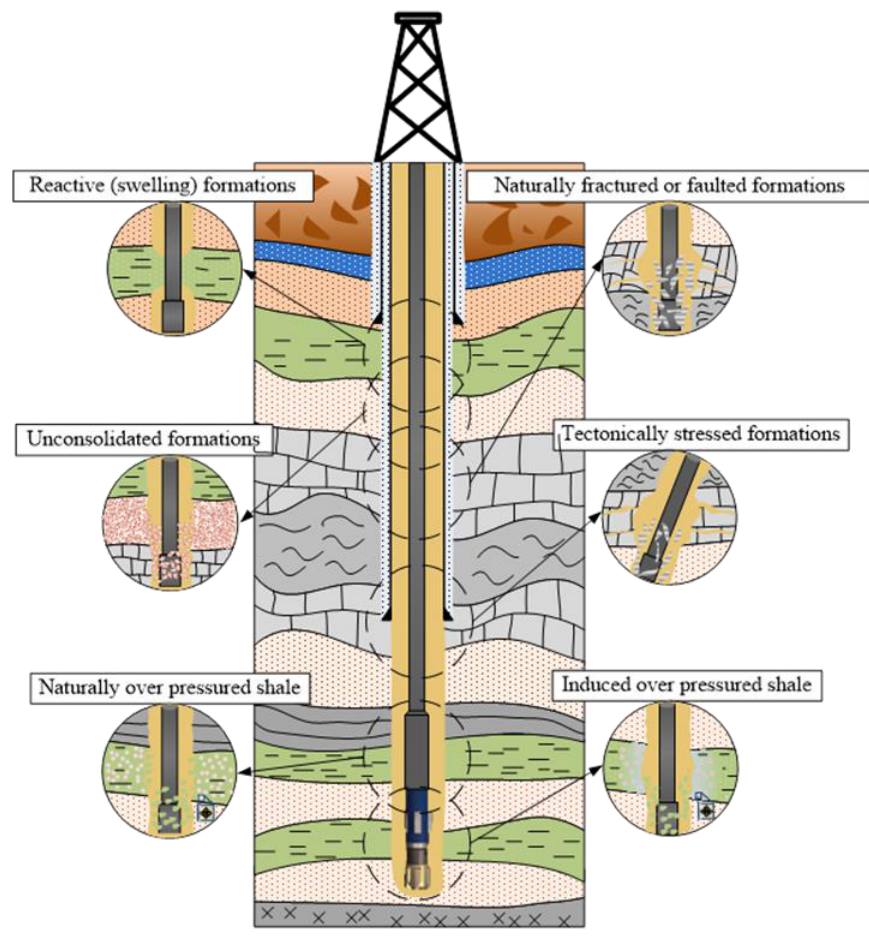
Figure 1. Examples of situations that can cause wellbore instability (according to [3]).